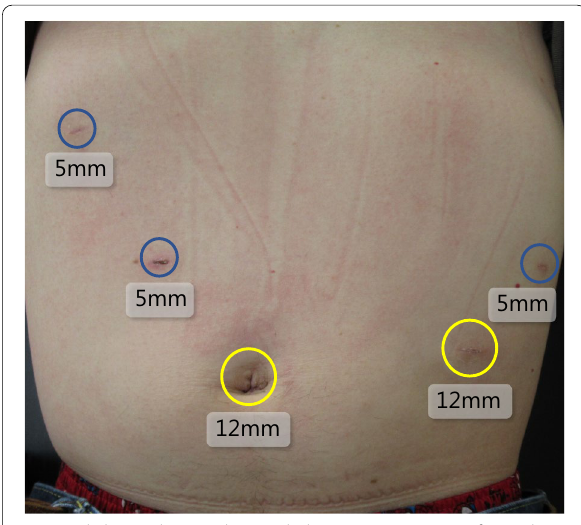
Fig. 2 Abdominal surgical wound. The operation was performed with five ports